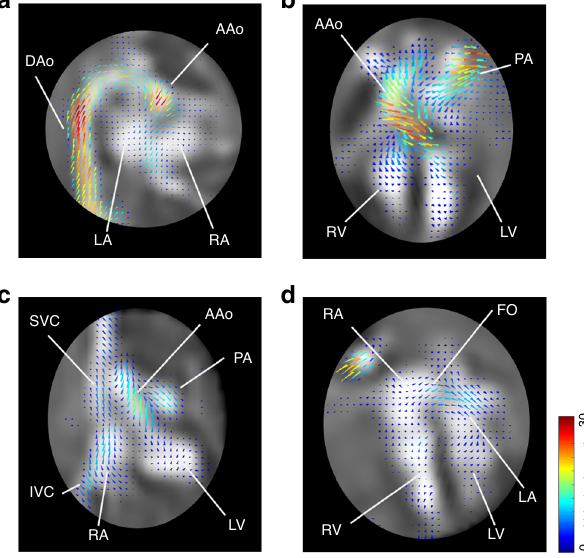
Fig. 3 Cross-sectional visualization of 4D fl ow cine volumes. Velocity vector plots in subject ID03 (healthy fetus 24 + 2 weeks gestational age) overlaid on corresponding 4D magnitude cine frames. a Aortic arch plane showing blood fl ow vectors curve around the transverse arch of the aorta and down the descending aorta (DAo). b Dual-ventricle view showing blood fl ow vectors emerging from the left ventricle (LV) and right ventricle (RV) and passing through the ascending aorta (AAo) and pulmonary artery (PA), respectively. c Four-vessel view showing vectors fl owing from the superior vena cava (SVC) and inferior vena cava (IVC) entering the right atrium (RA), and vectors passing through the AAo and PA. d Four-chamber view showing vector blood fl ow pass between the atria across the foramen ovale (FO).